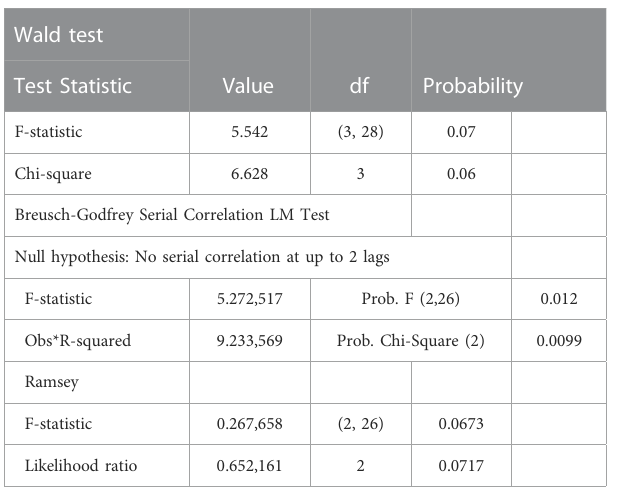
TABLE 6 Pairwise granger causality